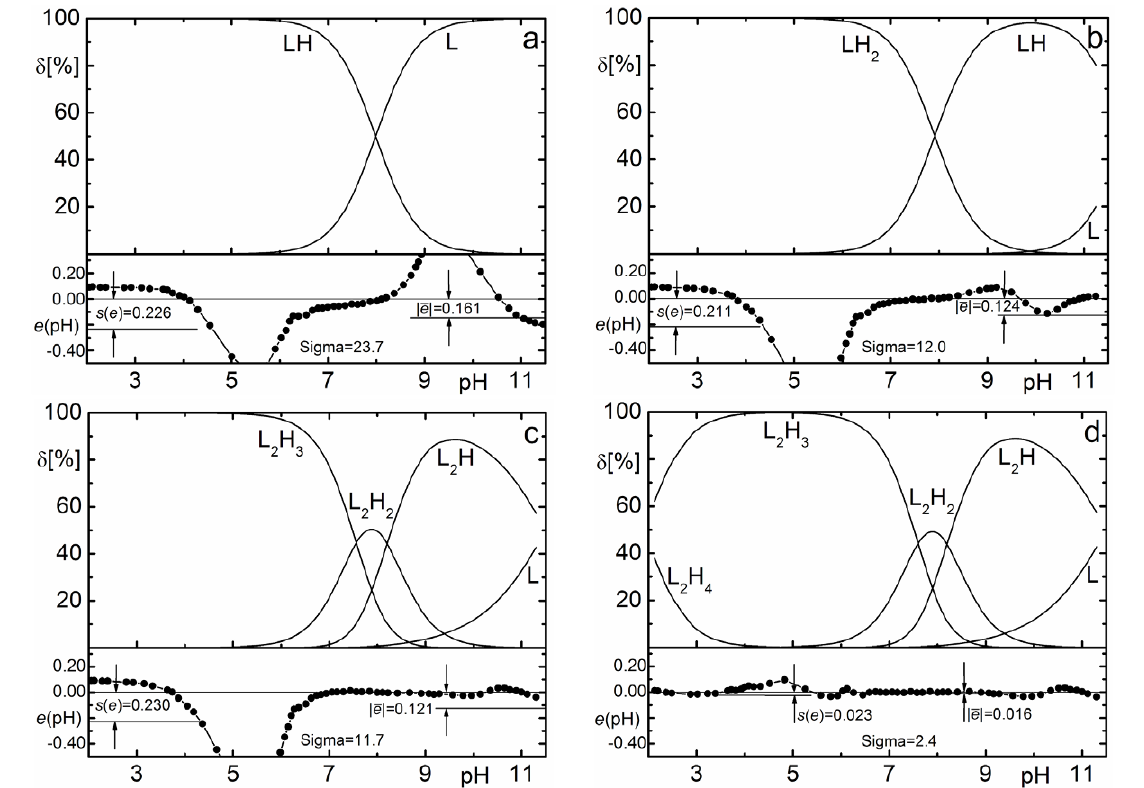
Figure 3. The search for the best chemical model for the formation of dimers in the system H + -vildagliptin by regression analysis of one